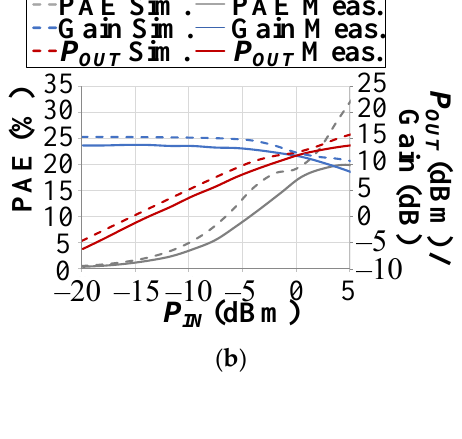
Figure 12. ( a ) Simplified schematics and ( b ) micrograph of the broadband 22 nm CMOS FD-SOI PA (620 µm × 500 µm with pads); ( c ) its S-Parameter post-layout PEX simulations vs. measurement; and ( d ) a comparison of its PEX S-parameters simulations with and without the RC feedback. The large-signal measured data vs. PEX simulation results at 24/28/44 GHz are shown in Figure 13, where degradation in the large-signal measurement data from simulations is seen, likely due to inaccuracies in the large-signal transistor modeling. These figures show that at 44 GHz, the measured gain is 3 dB higher than those of the PEX EM simulations. The measured gain values are usually reduced by 1 – 2 dBs from the simulated data at 24 – 39 GHz, while at 24/28/44 GHz this broadband PA achieves measured OP 1dB of 11.5/9.2/7.4 dBm with PAE @ OP 1dB of 18.6%/11.2%/9.3%, P SAT of 14.6/14.0/10.9 dBm, and maximum PAE of 26.1%/19.9%/12.5 %, respectively. Figure 14 plots the measured maximum PAE, S 21 , and P OUT,SAT vs. the frequency from 20 –44 GHz, which shows this PA maintains a maximum PAE ≥ 12.5% and P OUT,SAT ≥ 11 dBm across this frequency range. It achieves a maximum PAE ≥ 15.1% and P OUT,SAT ≥ 12.9 dBm across 24 – 39 GHz, highlighting the broadband performance of this CMOS PA.